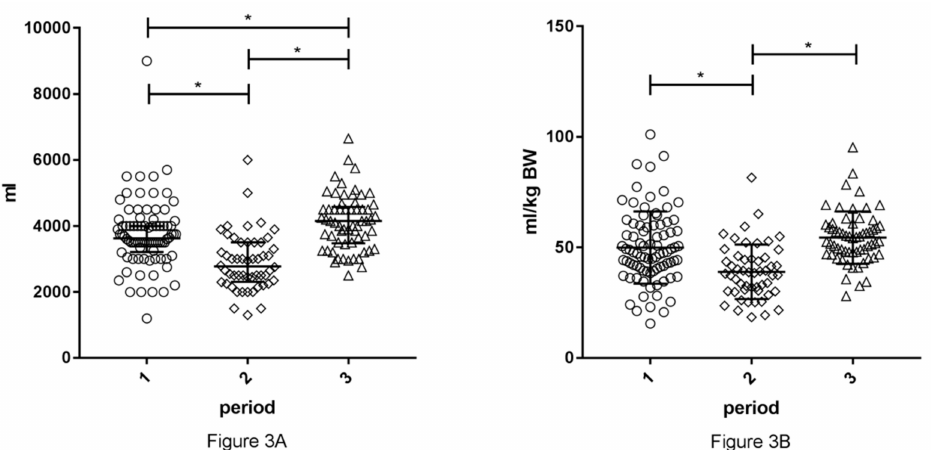
Figure 3. Volume of fluid administered intraoperatively in recipients during the di ff erent time periods. Period 1: January 2014–February 2015, old protocol, 4–5 L RL. Period 2: January–June 2016, GDFT protocol. Period 3: September 2016–February 2017, new protocol, 50 mL / kg BW. Volumes are given in mL ( A ) and mL / kg BW ( B